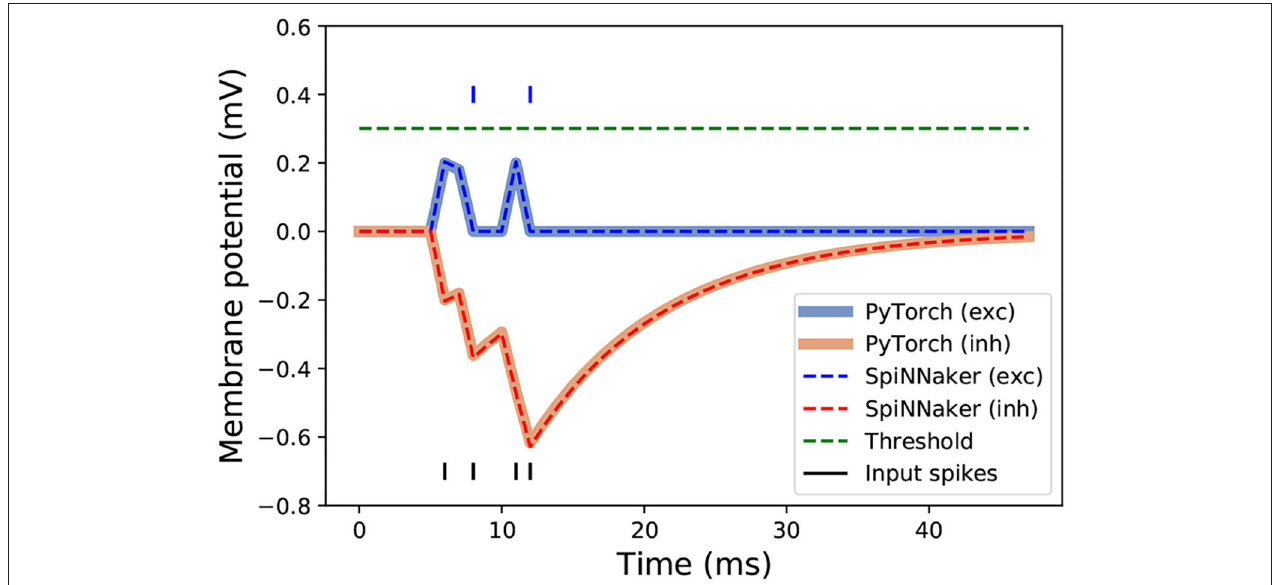
FIGURE 4 | Neuron responses to a single spike train, represented with black vertical segments at the bottom of the figure, in SpiNNaker and PyTorch. Responses of excitatory and inhibitory connections with weights of 0.2 are represented in blue and orange, respectively. The blue line segments above the threshold indicate the occurrence of output spikes from the excited neurons.